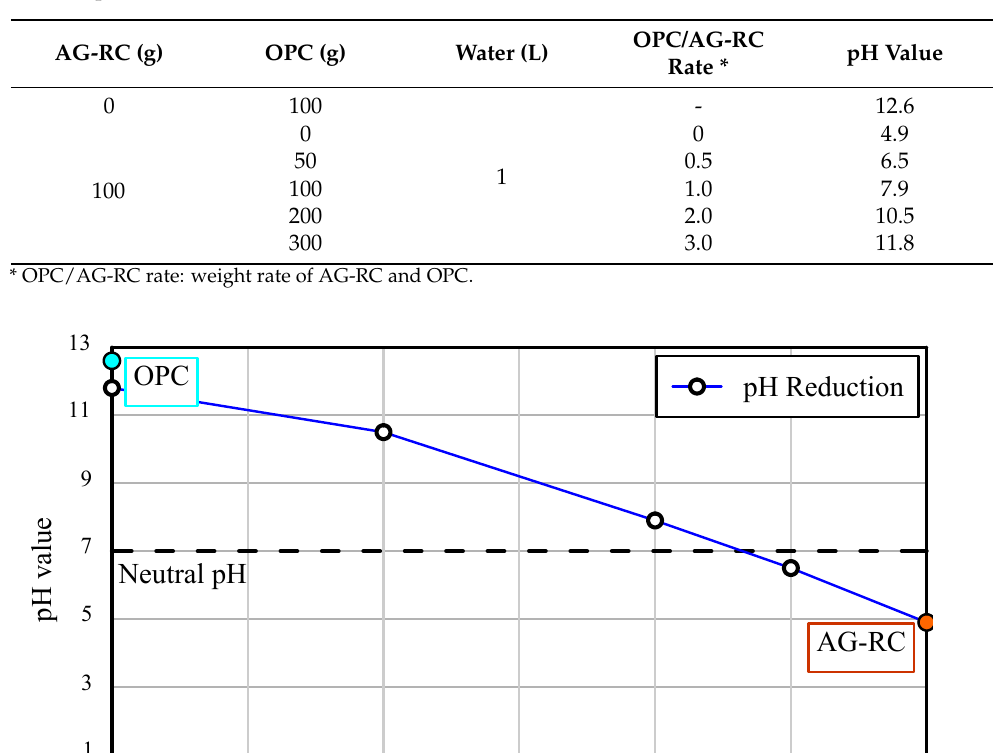
Table 5. pH reduction test results.